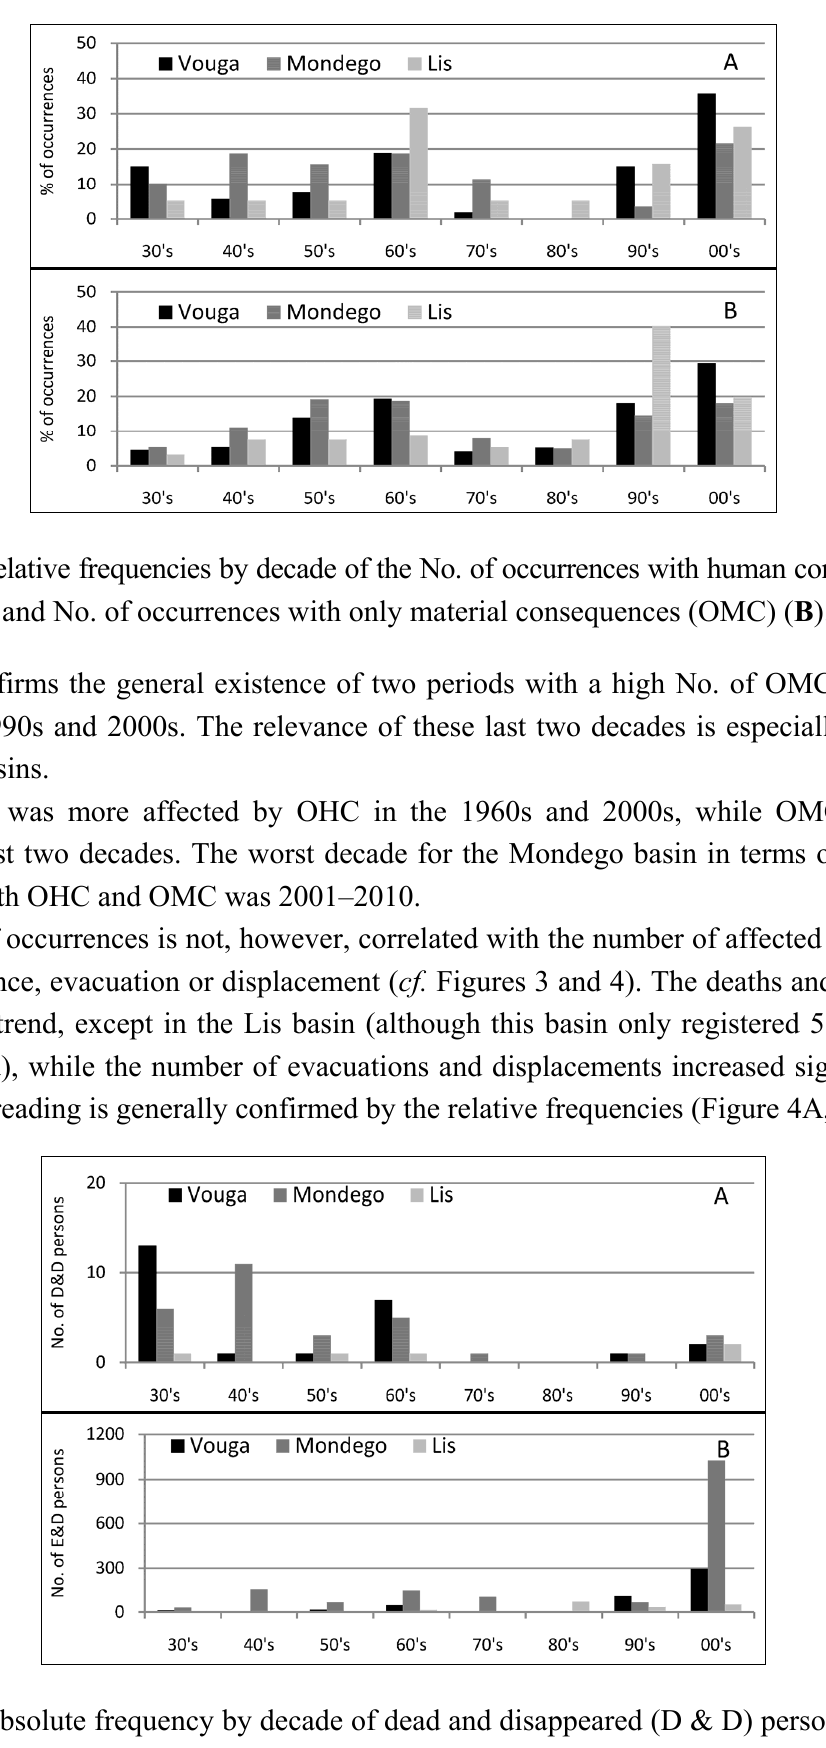
Figure 3. Absolute frequency by decade of dead and disappeared (D & D) persons ( A ) and evacuated and displaced (E & D) persons ( B